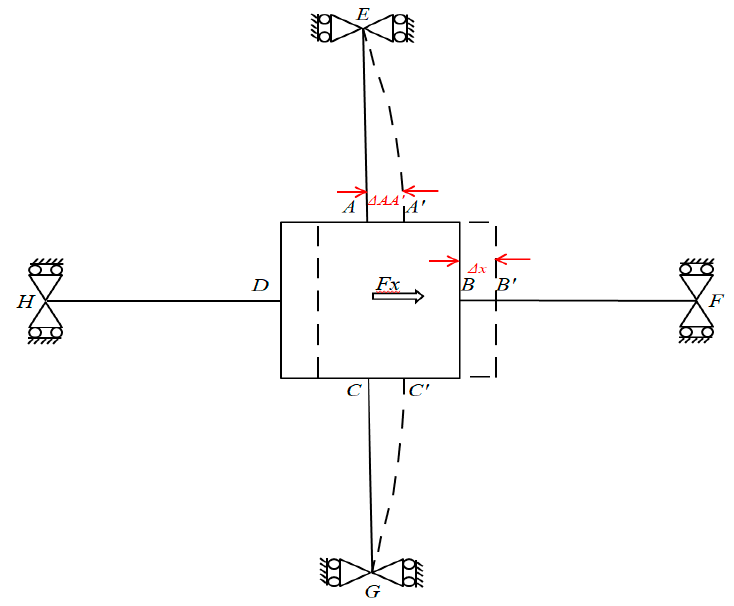
Figure 6. Deformation of the elastic body under force F x .